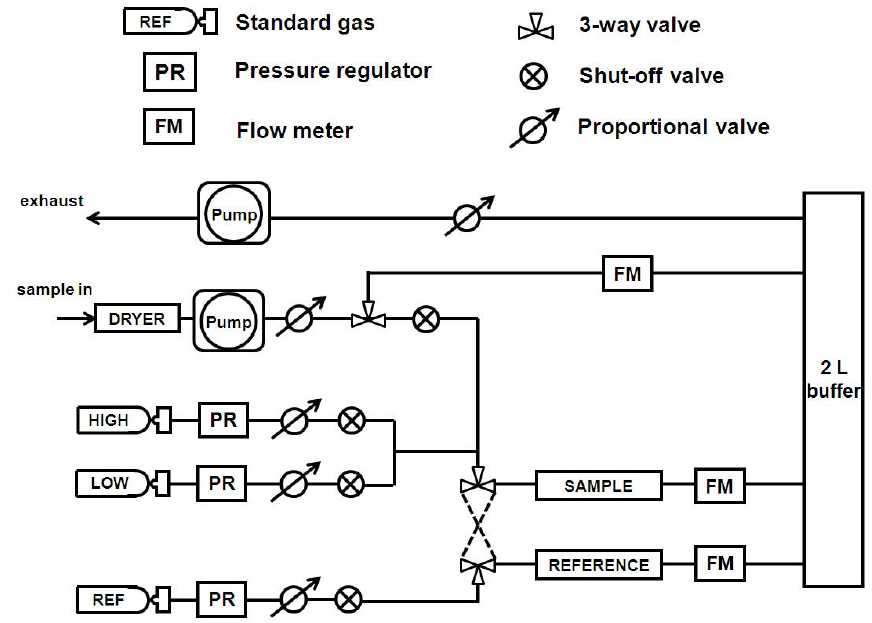
Fig. 1. Flow diagram of the CO 2 analyzer system. The system consists of three standard gases, labeled REF, HIGH, and LOW. The flow rates for different paths are controlled by actuating corresponding proportional